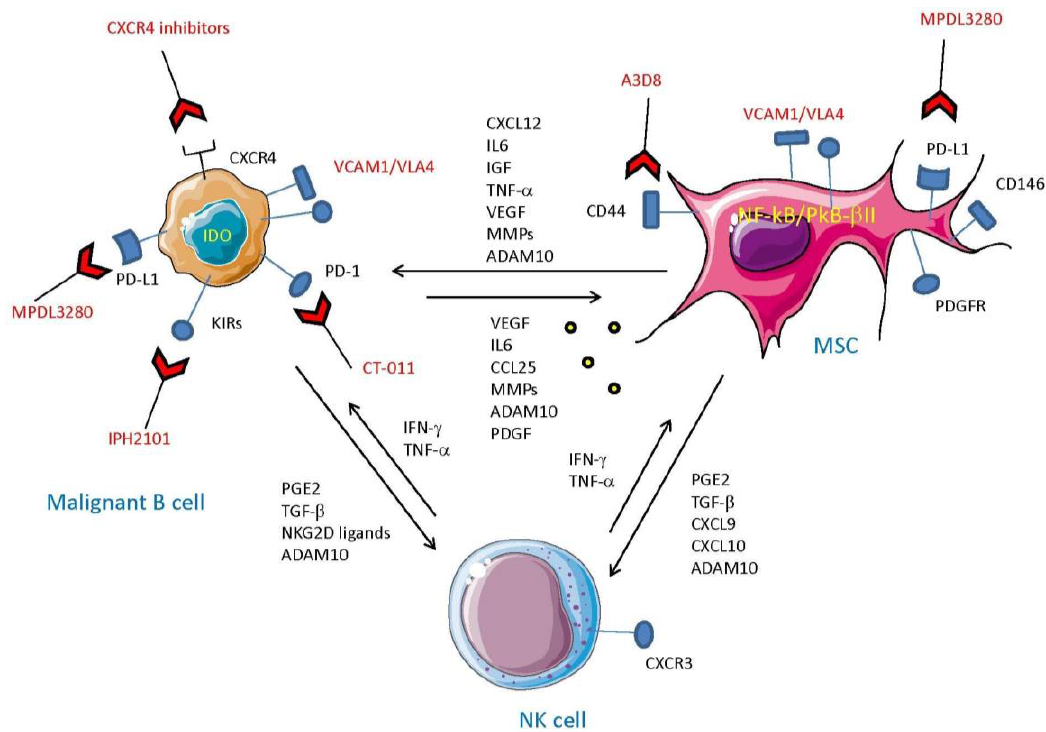
Figure 3. Interaction between mesenchymal stromal cells and malignant B cells to impair NK cell functions. The cross-talk between NK cells, MSC, and malignant B cells is complicated. NK cells producing IFN-γ and TNF-α can trigger both MSC and malignant B cells to produce inhibiting factors such as PGE 2 and TGF-β that in turn downregulate NK cell-mediated anti-tumor immunity. Furthermore, the complex interplay of cytokines and growth factors between MSC and B cells can promote the survival and proliferation of both cell types. The increase in TME of matrix metalloproteases (MMP) and ADAMs, also present in exosomes, can favor a strong release of soluble ligands for activating receptors of effector cells (e.g., NKG2D-L), leading to a more robust impairment of NK cell activation. The different molecular structures that can be targeted on B and MSC are shown for completeness. Indeed, anti-PD-1 and PD-L1 antibodies (CT-011 and MPDL3280), as well as CXCR4 inhibitors, target relevant surface molecules whose engagement can break the established loop between MSC and B cells, mitigating the inhibition of NK cells. It should be noted that leukemic cell killing can also be restored using anti-KIR antibodies (IPH2101), thereby impairing the interaction between KIR expressed on NK cells and HLA on tumor cells and blocking the KIR-mediated negative signals delivered to NK cells.